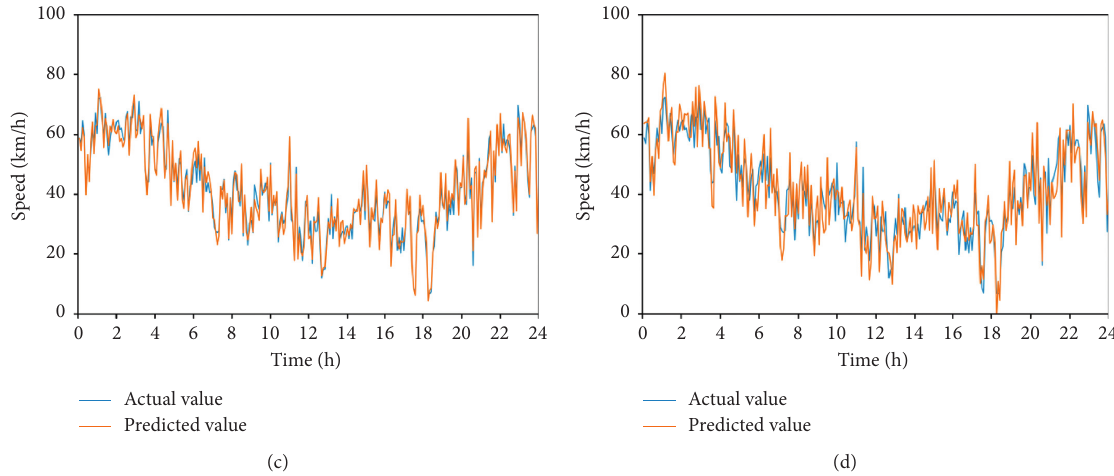
Figure 15: Comparison of prediction results by different sequence input methods: (a) trend series forecast; (b) residual sequence prediction; (c) trend and residual mixed forecast; (d) undecomposed sequence prediction.